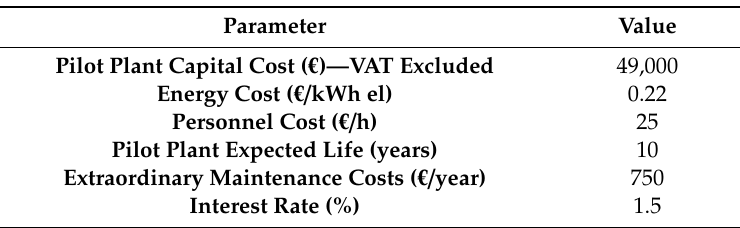
Table 4. Economic